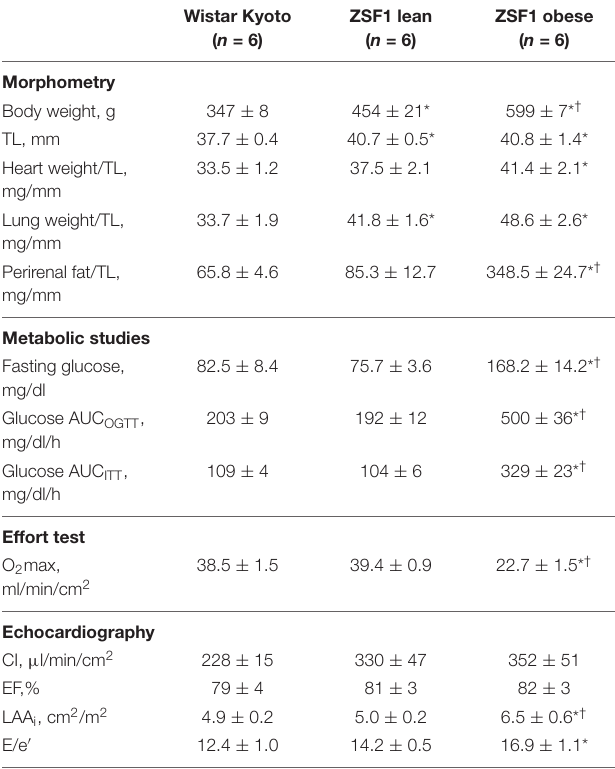
TABLE 1 | Hemodynamic and metabolic changes in ZSF1 obese rats. Wistar Kyoto ( n =